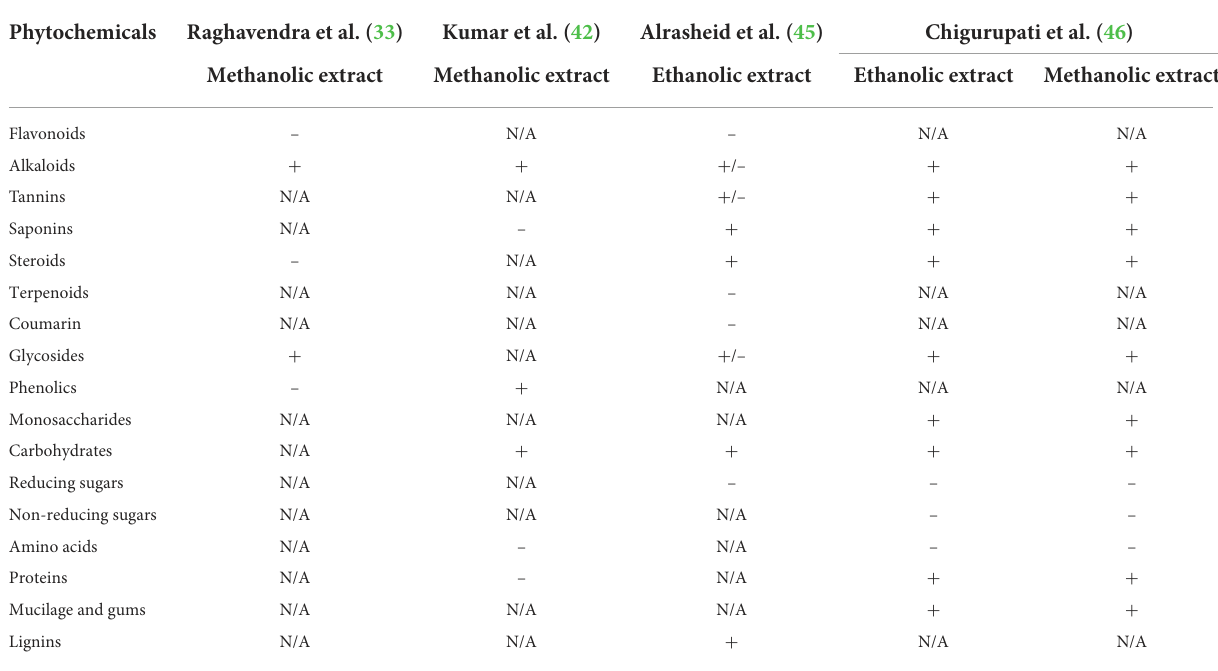
TABLE 2 Phytochemical screening of crude T. indica leaf extracts. Phytochemicals Raghavendra et al. (33) Kumar et al. (42) Alrasheid et al. (45) Chigurupati et al. (46) Methanolic extract Methanolic extract Ethanolic extract Ethanolic extract Methanolic